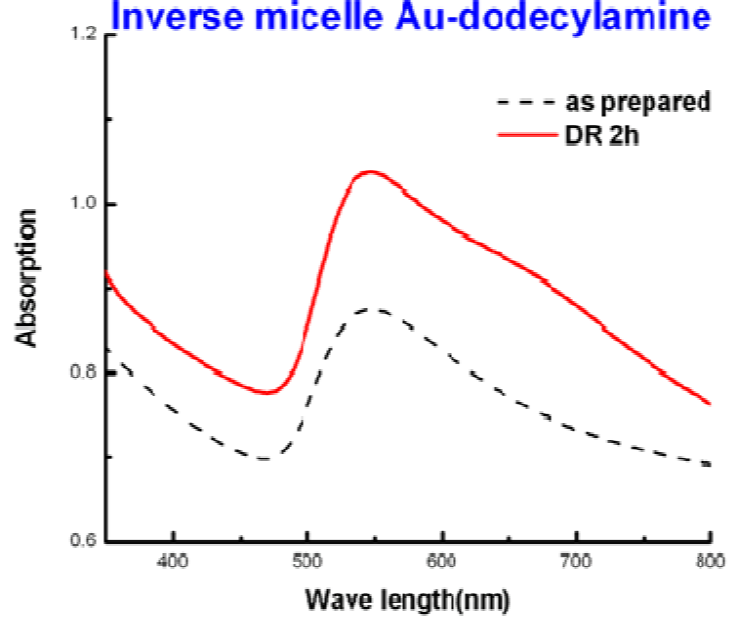
Figure 9. UV-Visible spectrum of Au-dodecylamine colloid by inverse micelle method before and after digestive ripening 2 h in